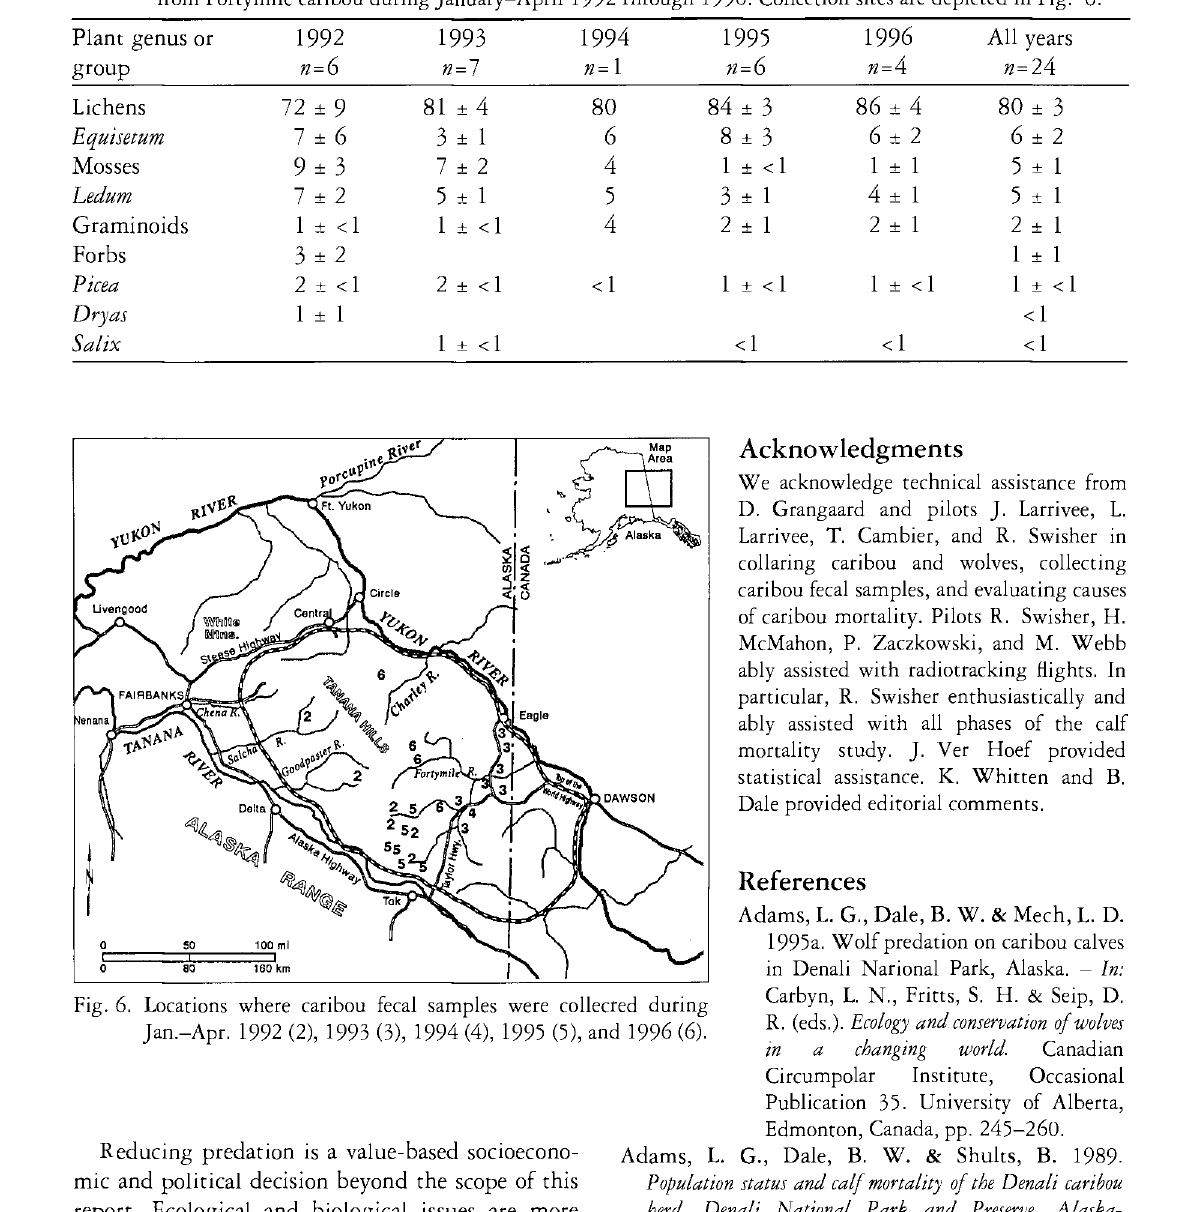
Table 8. Proportions of discerned plant fragments (mean % ± standard error of the mean) in 24 fecal samples collected from Fortymile caribou during January-April 1992 rhrough 1996. Collection sites are depicted in Fig. 6. Plant genus or